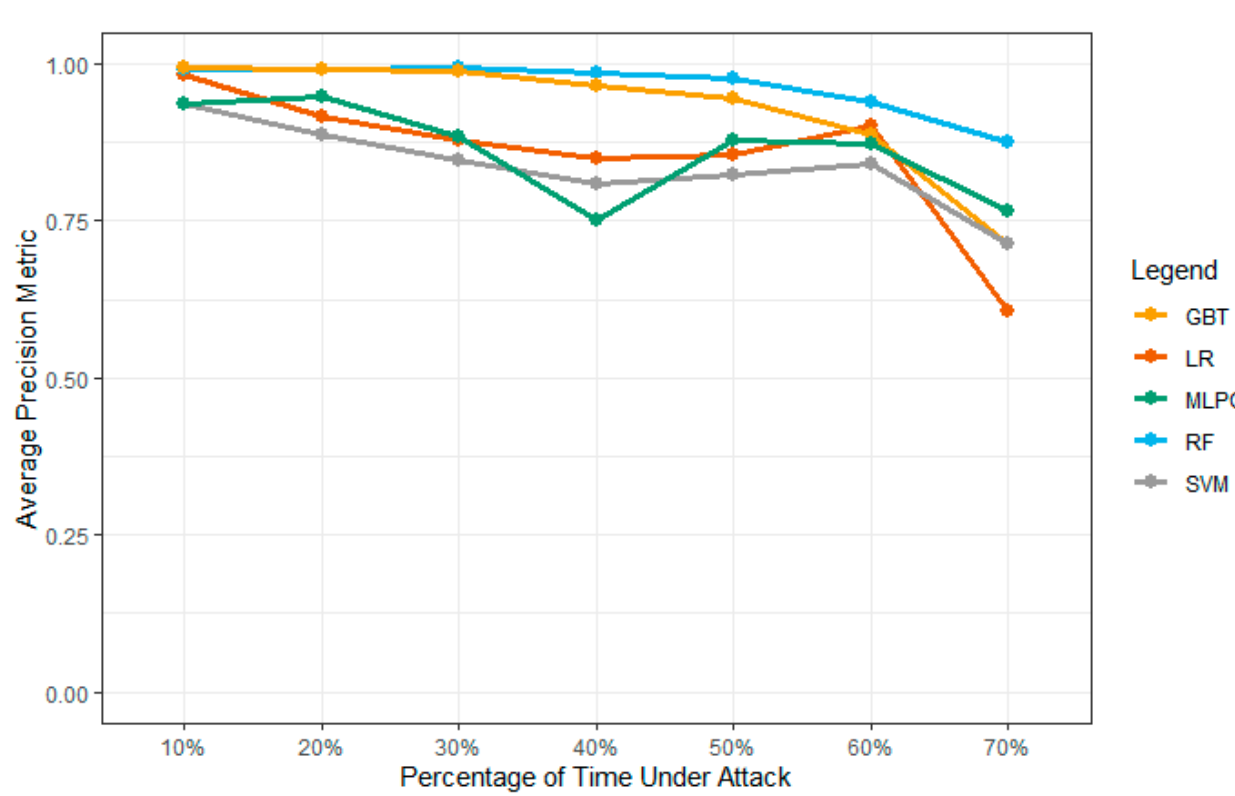
Figure 14. Models’ accuracy over multiple nodes.